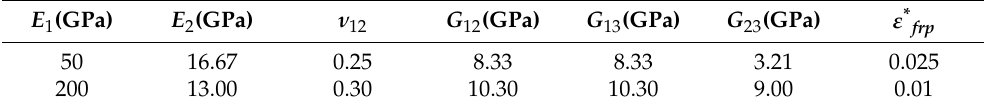
Table 3. Mechanical properties of FRP laminates used in parametric studies.